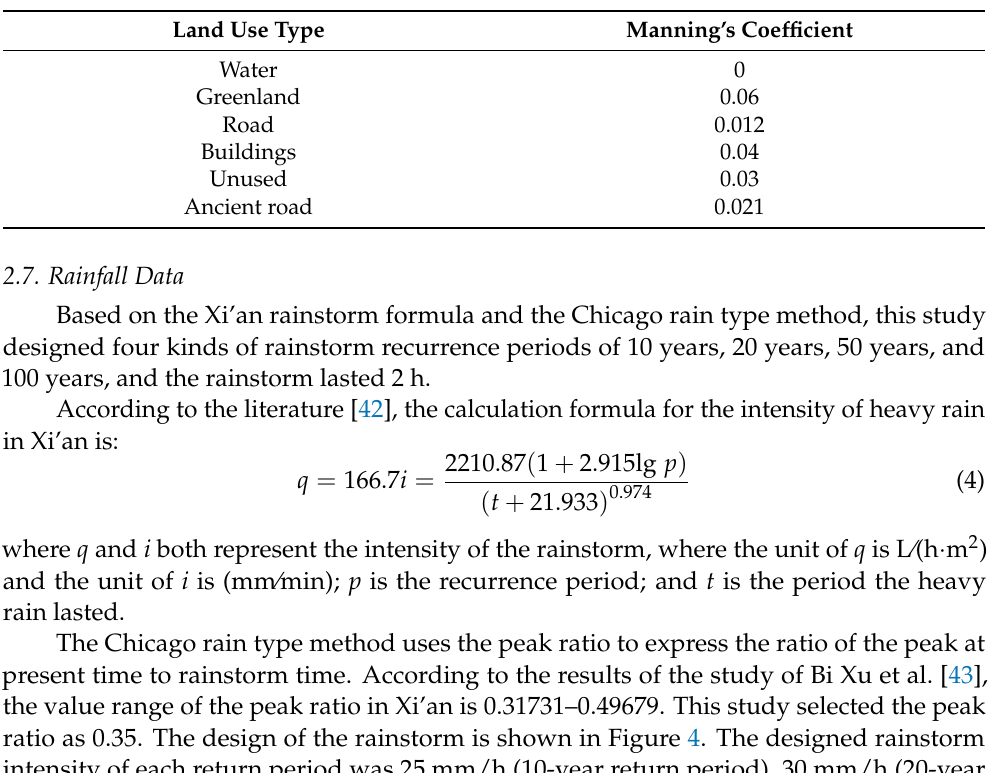
Table 2. Manning’s coefficient